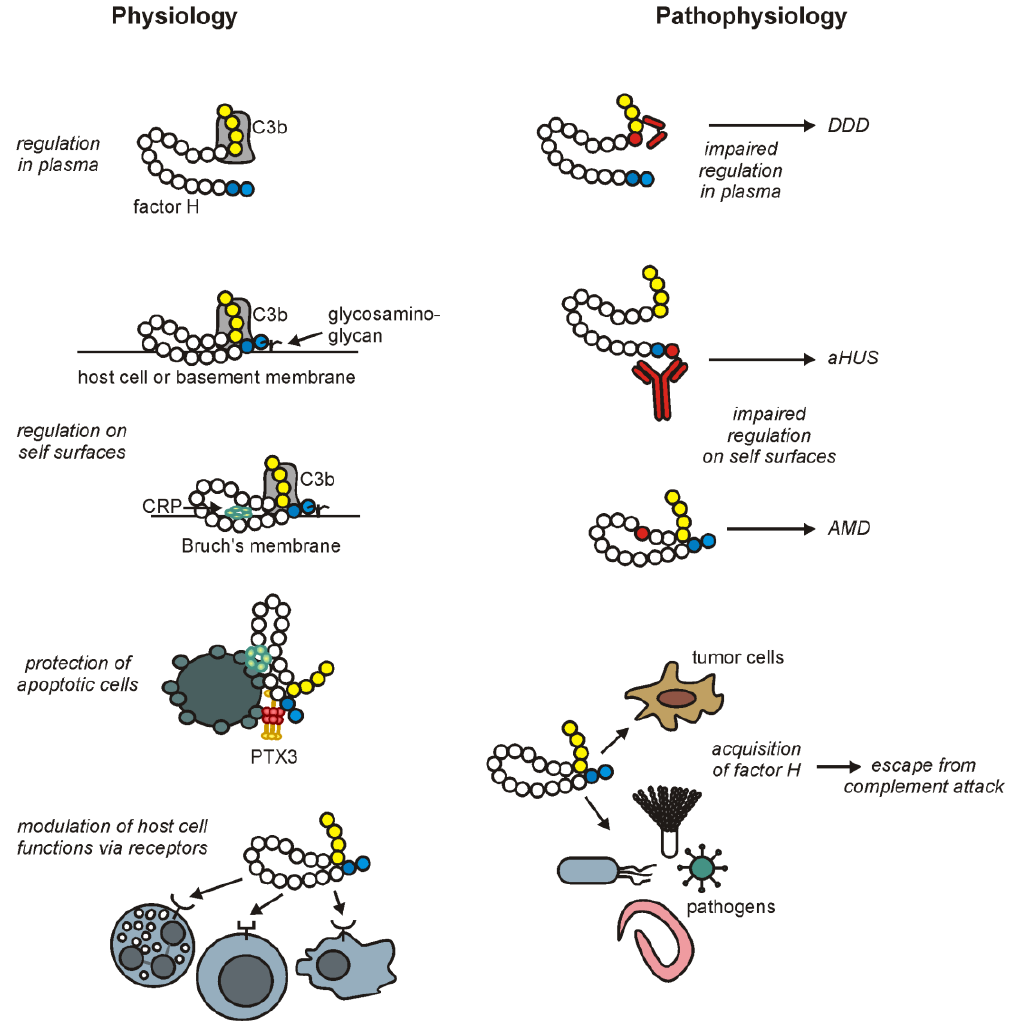
Figure 3. Overview of main factor H functions and their implication in pathological conditions . Factor H is a major soluble complement regulator that inhibits activation of the alternative complement pathway in body fluids. In addition, factor H is also able to control complement activation on self-surfaces and thereby protects host cells and tissues from complement attack. Factor H binds to host cells and basement membranes via interactions with glycosaminoglycans and deposited C3b. The binding of factor H to apoptotic cells and extracellular matrices is in part mediated by the pentraxins CRP and PTX3, and is of particular importance as these structures and cells are otherwise not well protected from complement. Furthermore, factor H interacts with host cells via specific receptors and thus modulates cellular functions, including adhesion and phagocytosis. Impaired functions of factor H are associated with several diseases such as DDD, aHUS and AMD. Mutations in the CFH gene (examples of affected domains are shown in red) or autoantibodies directed against factor H (“mini-autoantibody” in DDD and anti-factor H IgG in aHUS are shown in red) cause defective complement regulation and ligand recognition leading to improperly controlled inflammation and tissue damage. On the other hand, the regulatory functions of factor H are abused by several pathogens and tumor cells in order to protect themselves from complement attack and thus to evade the host immune